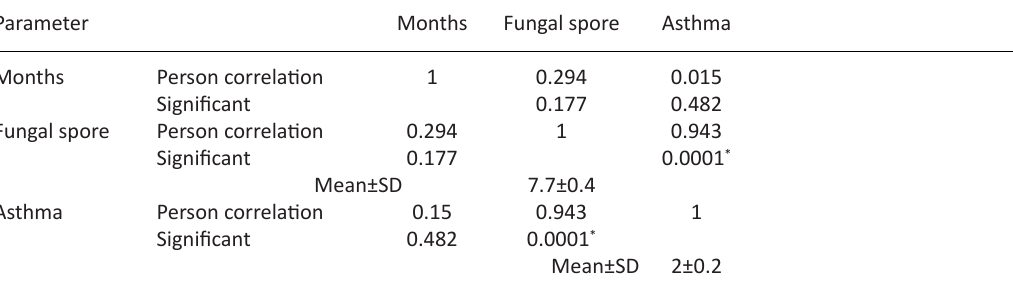
Table 1. Correlation between fungal spore count in dust and the number of patents has asthma Parameter